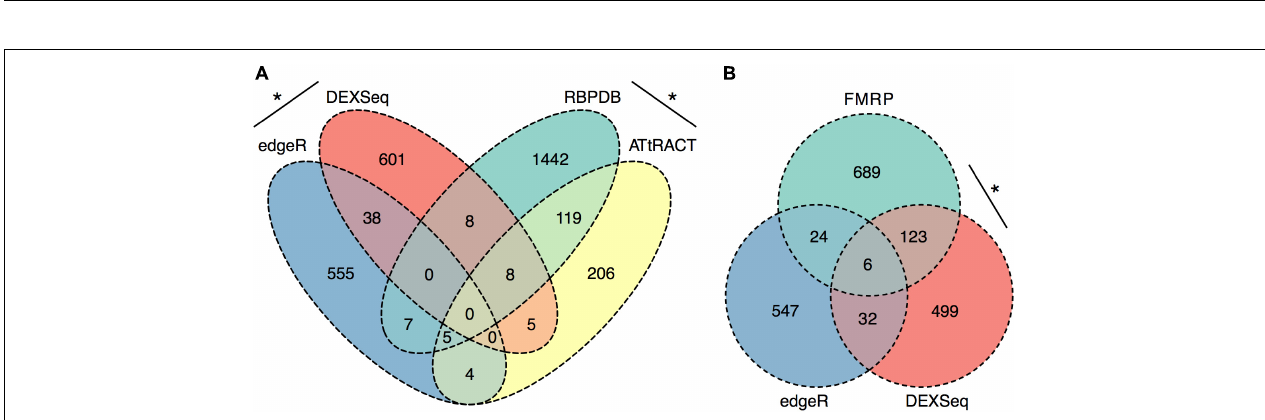
FIGURE 4 | DEU in P2 and S2 fractions following acute ethanol exposure or sensitization. The number of differentially utilized exons ( p adj < 0.01) and unique genes possessing a minimum of one differentially utilized exon observed in the P2 (A) and S2 (B) fractions following acute ethanol exposure or sensitization. Gene Ontology reduction plots depicting clustering of top biological processes associated with ethanol sensitization and acute exposure induced DEU are displayed for the P2 (C) and S2 (D) fractions.